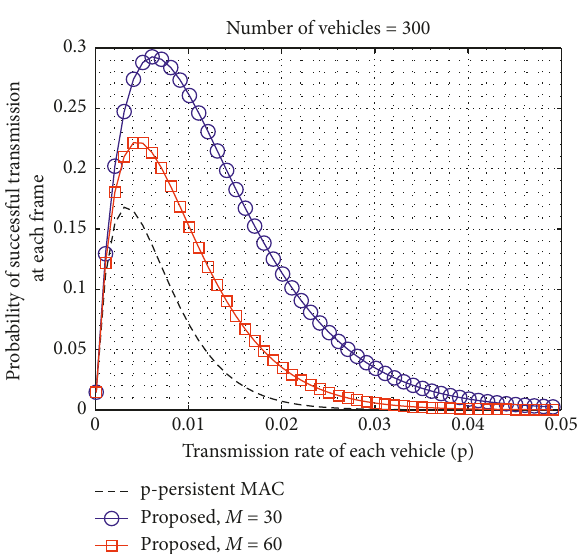
Figure 7: Simulation results.